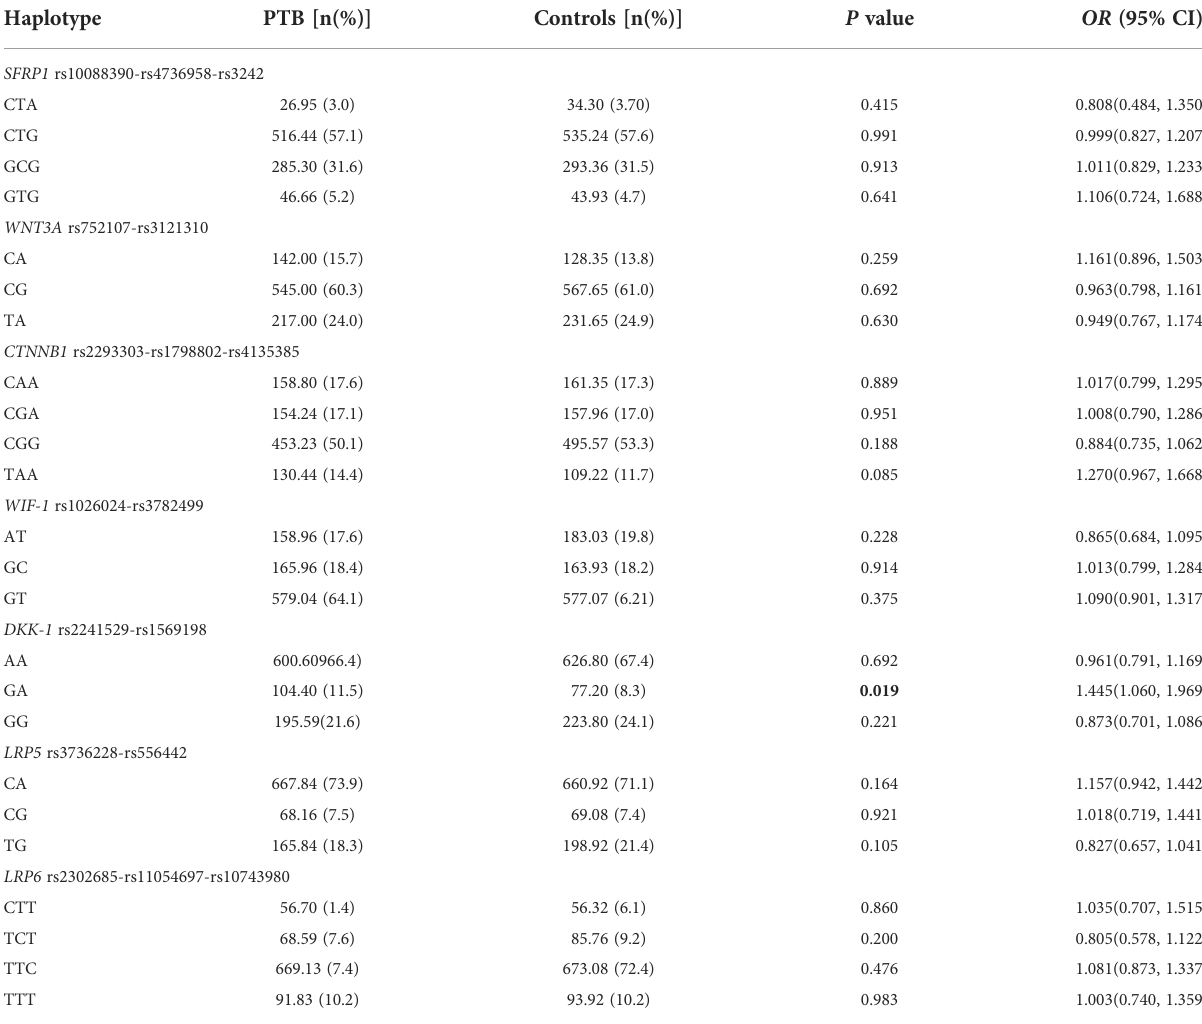
TABLE 2 Haplotype analysis of WNT pathway genes in PTB patients and controls.